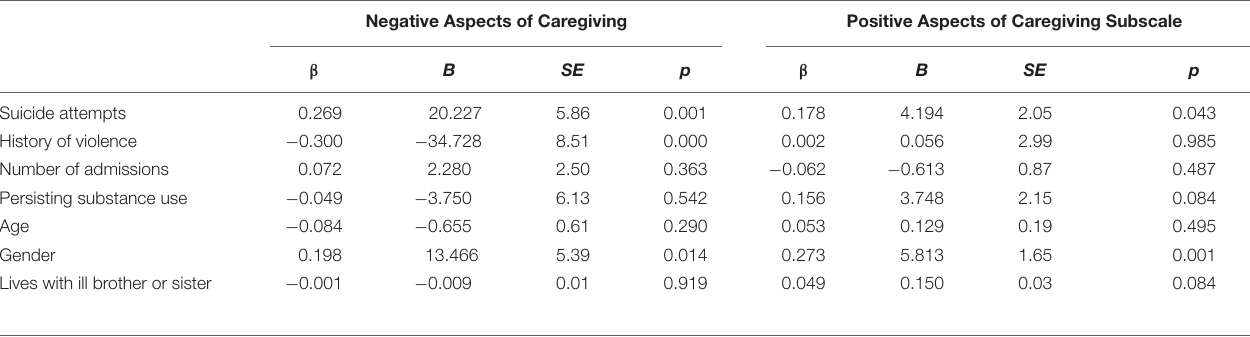
TABLE 7 | Standardized ( β ) and unstandardized ( B ) regression coefficients from two standard regression analyses with the total negative and positive subscales serving as dependent variables in each model and the predictors including suicide attempt, history of violence, number of admissions, substance use, age and gender.